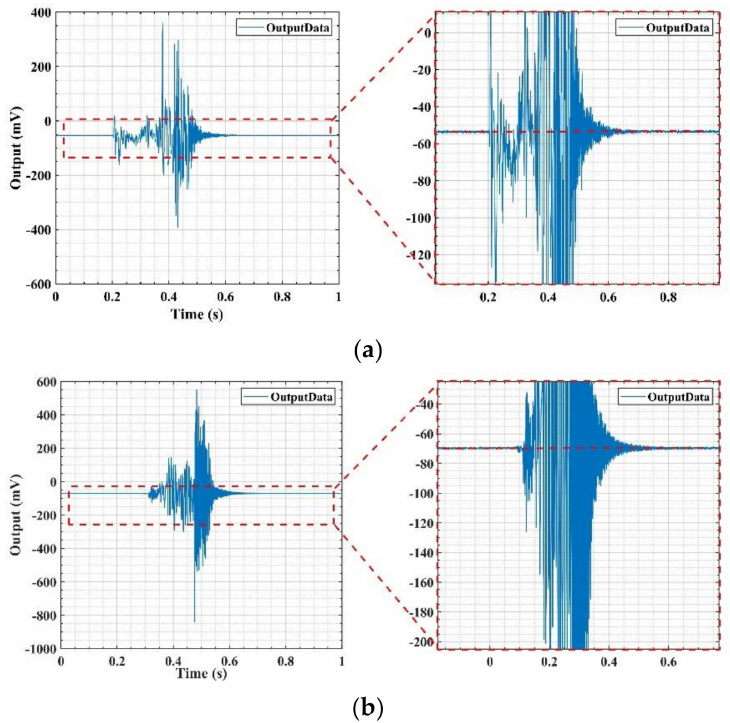
Figure 21. Output of gyroscope with V-shaped beam thickness of 80 µ m after ( a ) Z + shock direction and ( b ) Z − shock direction.